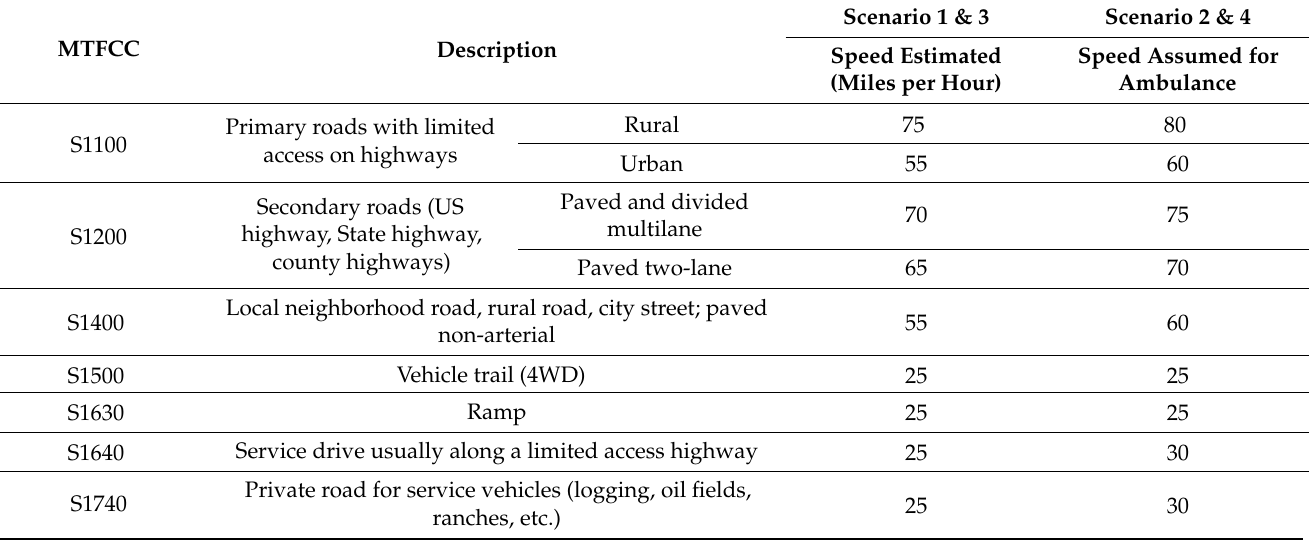
Table 2. Assumed travel speed